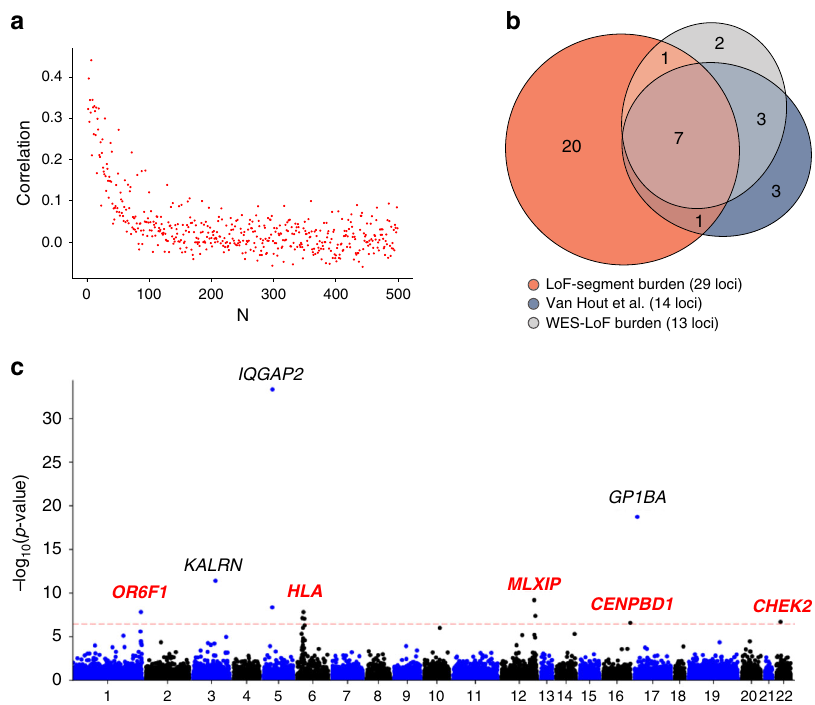
Fig. 5 IBD sharing and rare variant associations. a Correlation between IBD sharing (average number of IBD segments per pair across UK postcodes in the past 10 generations in the UK Biobank ’ s 487,409 samples) and ultra-rare variants sharing (average number of F N mutations per pair across UK postcodes in the UK Biobank 50k Exome Sequencing Data Release for increasing values of N ). b Venn diagram representing the sets of exome-wide signi fi cant associated loci for 7 blood-related traits using three methods: the WES-based LoF burden test reported by Van Hout et al. 49 , a WES-based LoF burden test we performed (WES-LoF burden), and the IBD-based LoF burden test we performed (LoF-segment burden). The corresponding p -values were computed using two-sided t -tests and are reported in Tables 1, 2 and Supplementary Table 8. c Exome-wide Manhattan plot for mean